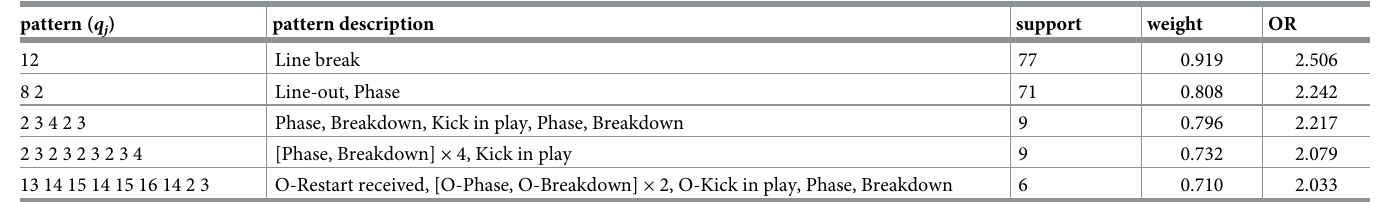
Table 5. Top five SPP-obtained patterns that discriminated the most between scoring and non-scoring outcomes. pattern ( q ) pattern description j